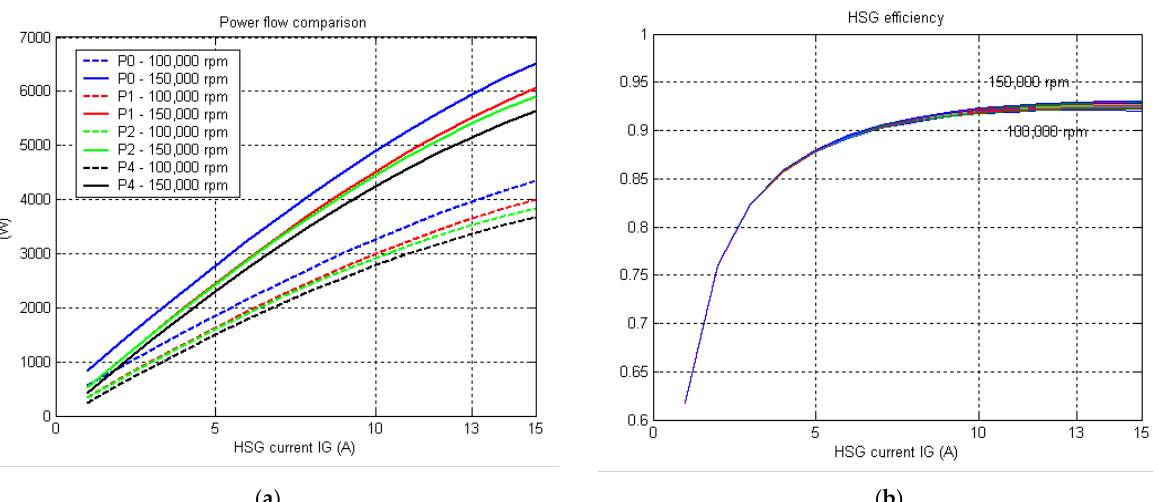
Figure 12. ( a ) Comparison of Power flows (mechanical Power (P0), active Power (P1), rectified Power input to the Electronic Load (P2), and Power injected to the grid (P4)) as a function of generator current IG at different speed levels; ( b ) HSG calculated efficiency as a function of the generator current IG varying the MGT speed from 100 to 150 krpm.